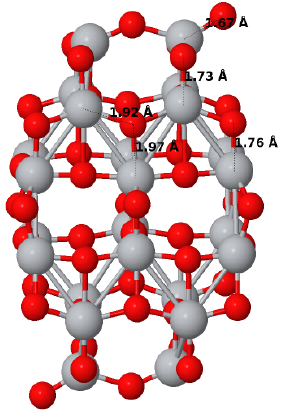
Fig. 1. Optimized geometry of a 72 atom TiO 2 anatase nanoparticle with bond length results prepared from 3×2×1 unit cells.